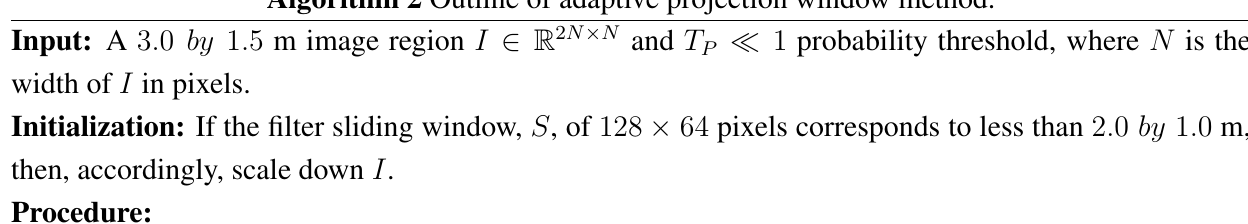
Algorithm 2 Outline of adaptive projection window